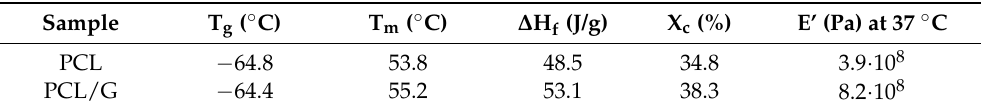
Table 1. Glass transition temperature (T g ), melting temperature (T m ), enthalpy of fusion ( ∆ H f ), degree of crystallinity (X c %) and storage modulus (E’) at 37 ◦ C.